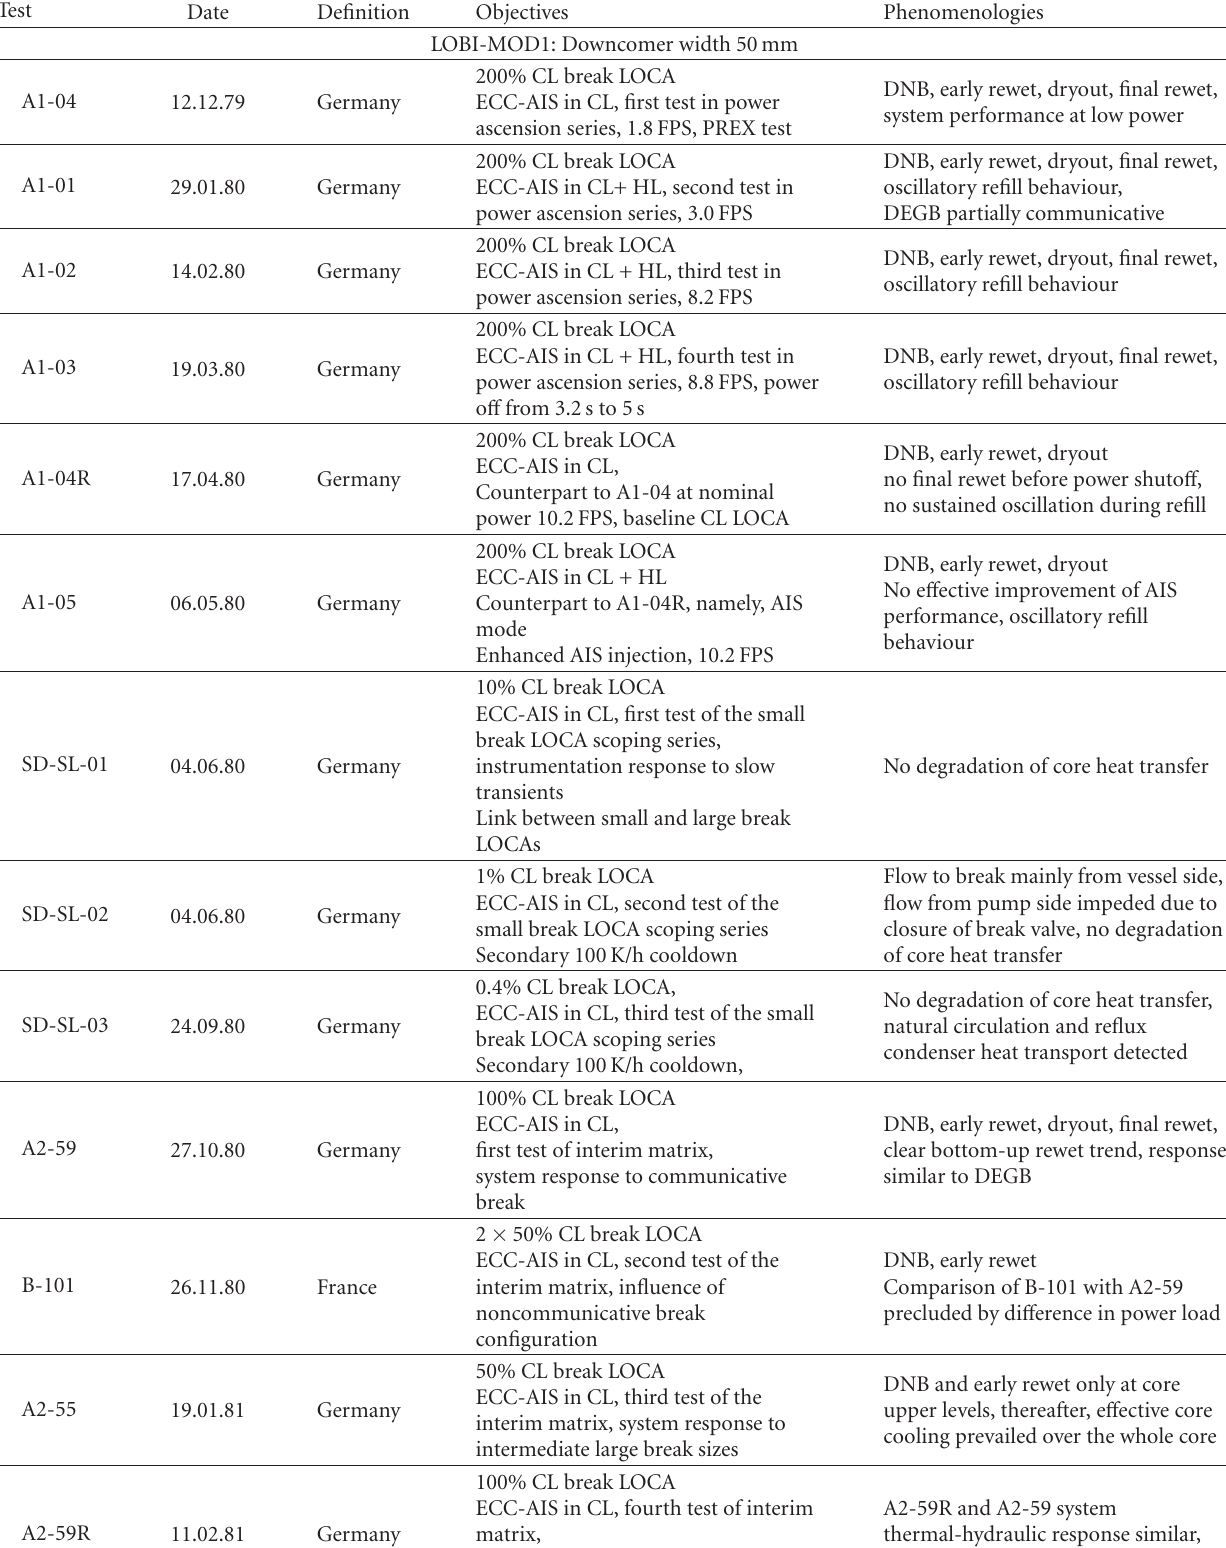
Table 2: LOBI-MOD1 and LOBI-MOD2 test